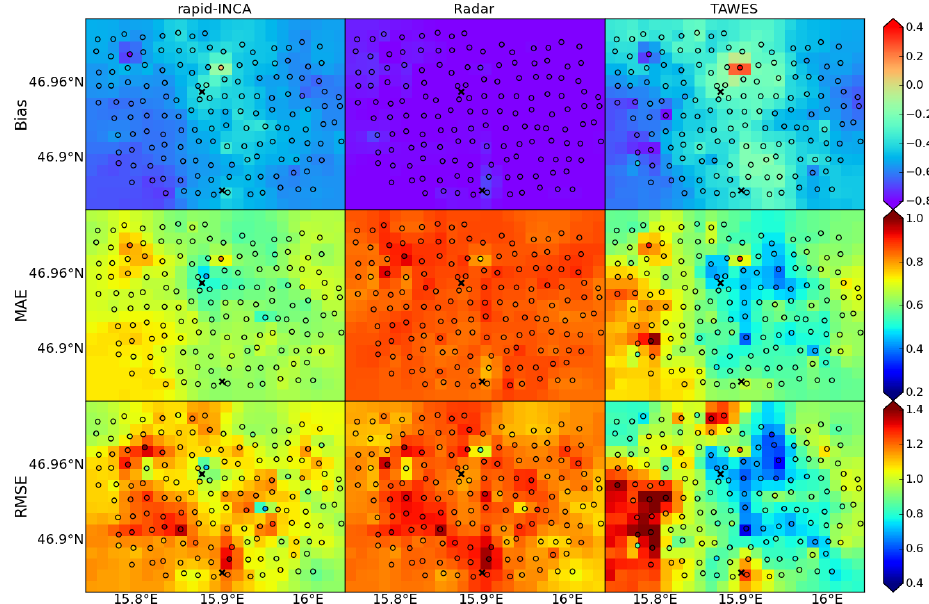
Figure 12. Relative bias, MAE and RMSE for rapid-INCA, radar and TAWES stations at each WegenerNet station. Only those data points are included where the WegenerNet station measured more than 0.5mm/5min. Circles represent exact values at the WegenerNet stations; the image is obtained by IDW interpolation to the INCA